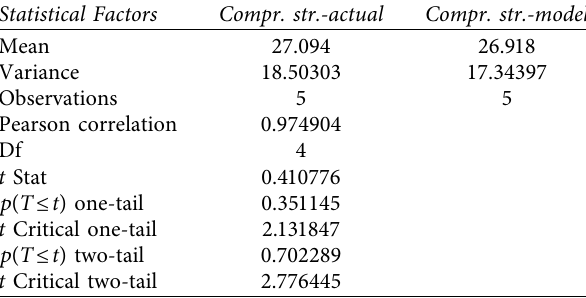
Table 29: T -Test: paired two-sample test for means for compressive strength response.